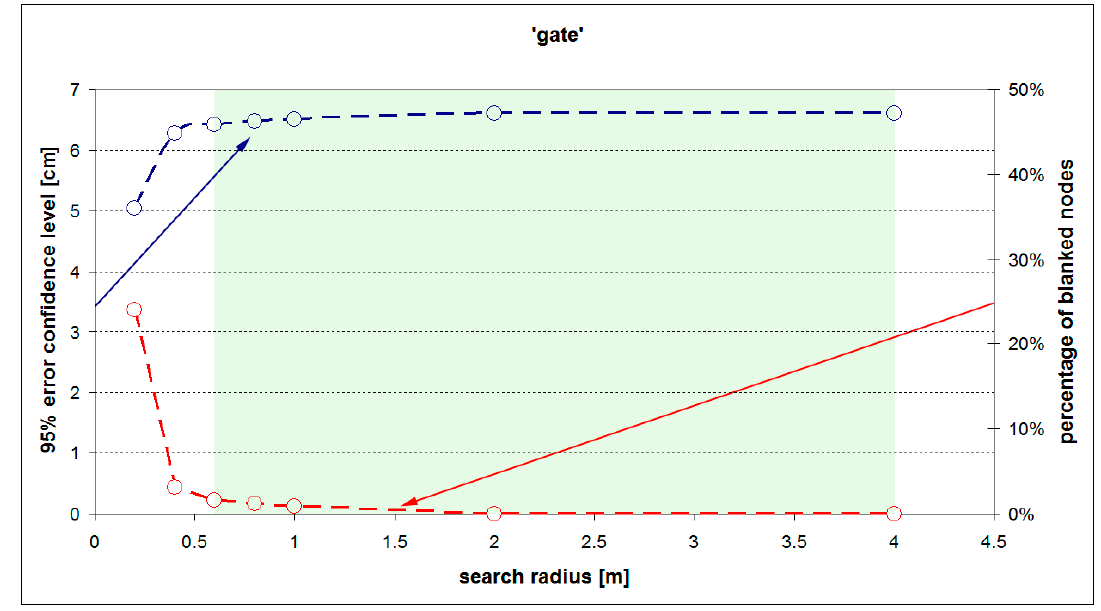
Figure 3. The results for ‘gate’ surface with different search radius values.